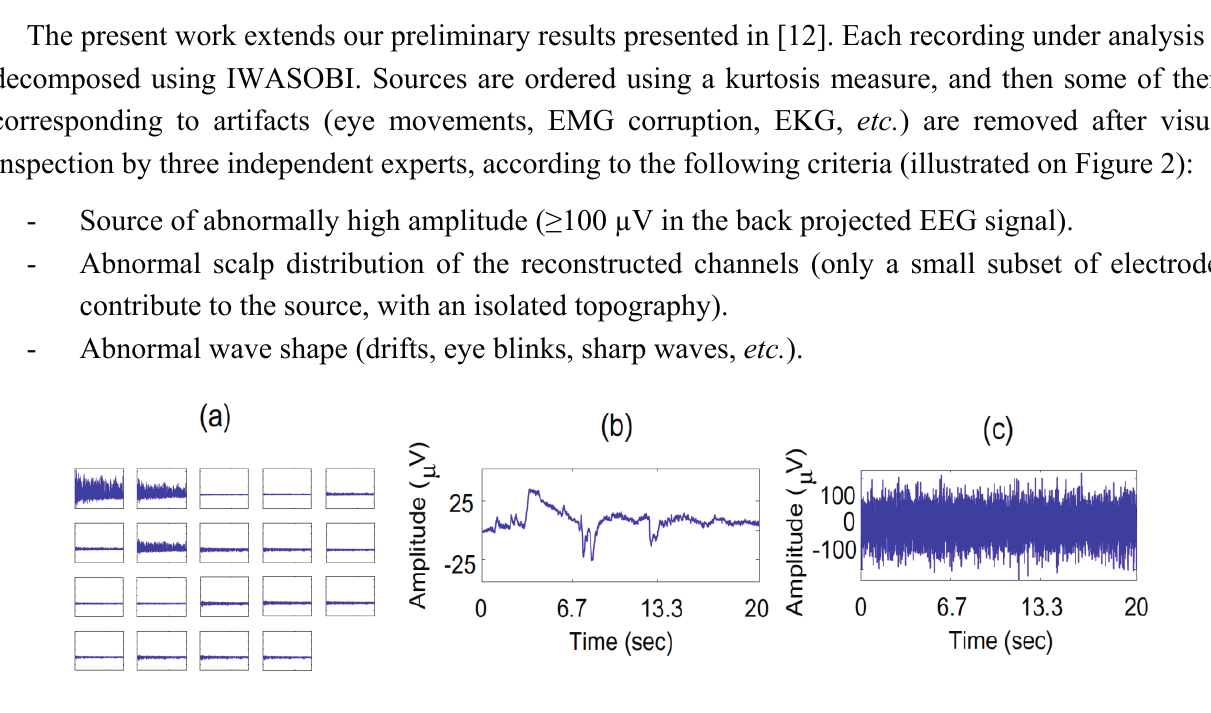
Figure 2. Examples of artifacts: ( a ) abnormal scalp distribution of the reconstructed channels; ( b ) abnormal wave shape; ( c ) source of abnormally high